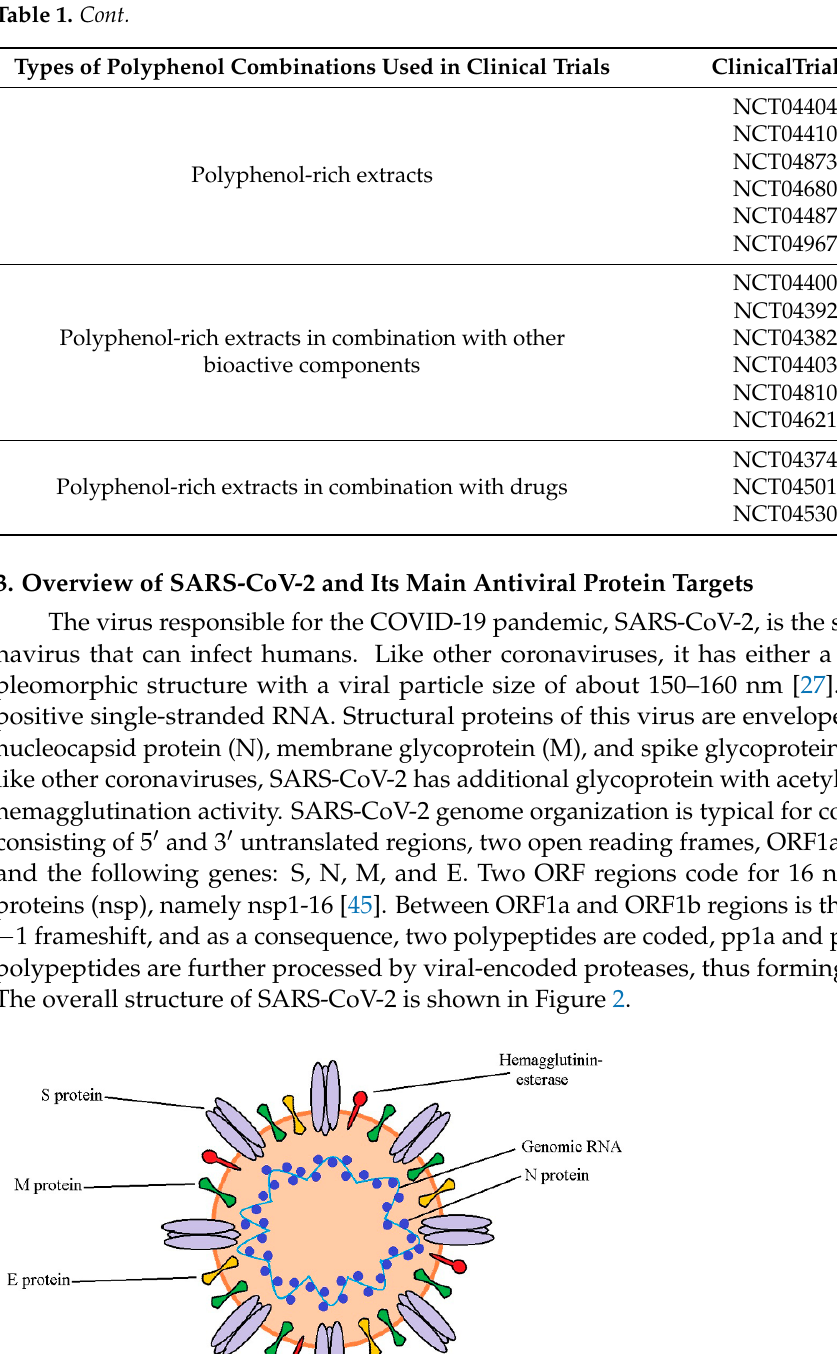
Polyphenol-rich extracts